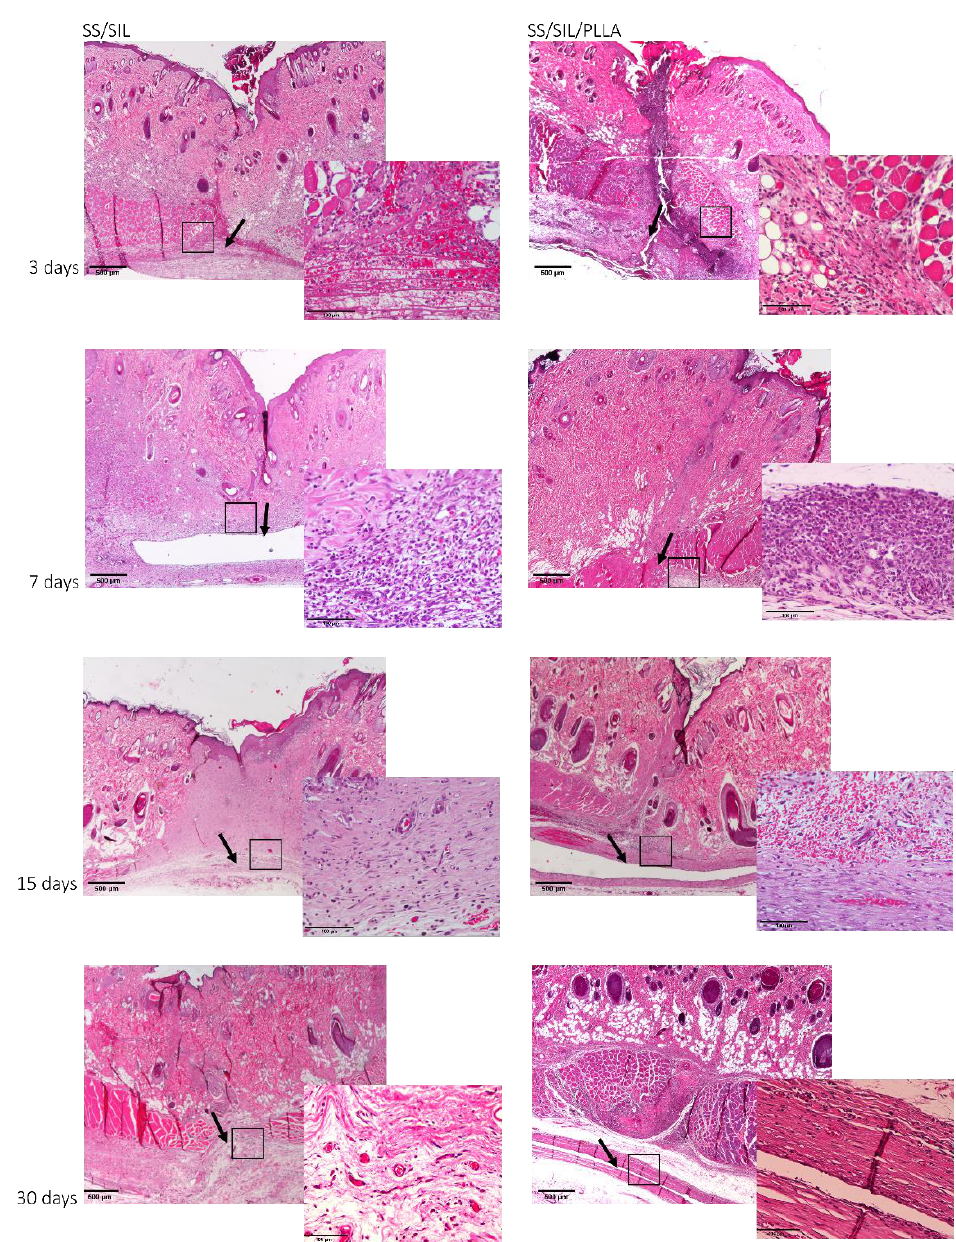
Figure 8. Histological analysis following H&E staining for SS/SIL and SS/SIL/PLLA devices. Evaluation of the sections was performed with a Nikon microscope (Nikon Eclipse E600) coupled with a photo camera (Nikon Digital Sight DS-5M). The left panel corresponds to SS/SIL devices and the right panel to SS/SIL/PLLA devices. For each panel, the left image corresponds to a magnification of 20 × (scale bar 500 µ m) and the left image to a total magnification of 200 × (scale bar 100 µ m). Black arrows represent the implantation site and insets indicate 200 × magnification images’ acquisition site.